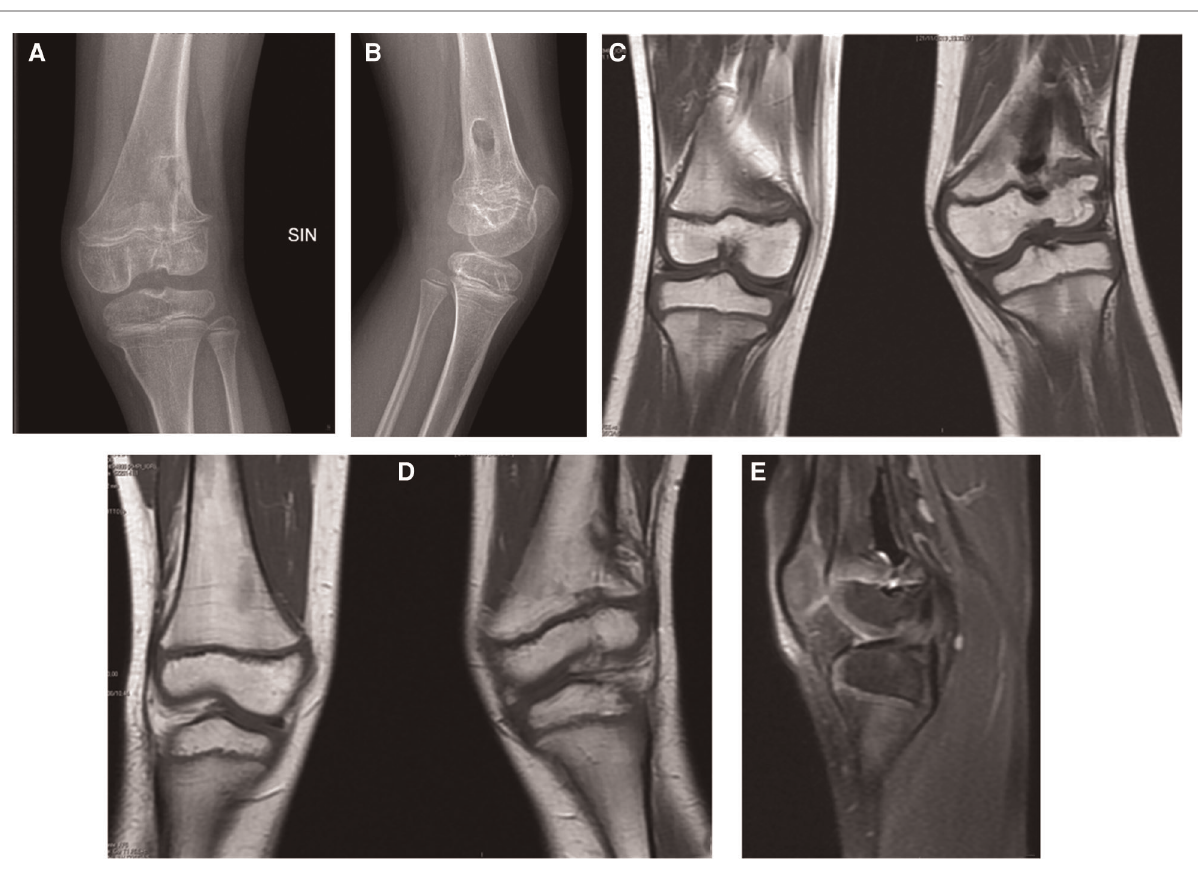
FIGURE 4 X-ray ( A,B ) and MRI ( C – E ) highlighted the results of the recent de-epiphysiodesis operation with placement of bone wax and minimal residual bone